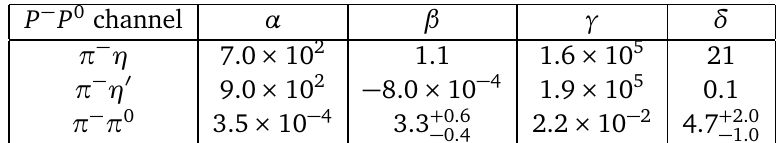
Table 2: Numerical values of coefficients in Eq. (8) [ 3,4 ] for different hadronic channels in τ − → π − P 0 ν τ decays. Error bars stemming from theoretical form factors is provided only for the π − π 0 channel.